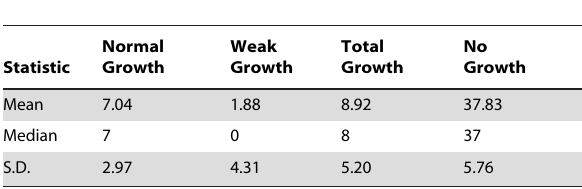
Table 1. Summary statistics for the number of carbon sources with normal and weak growth phenotypes across 448 strains of Saccharomyces .